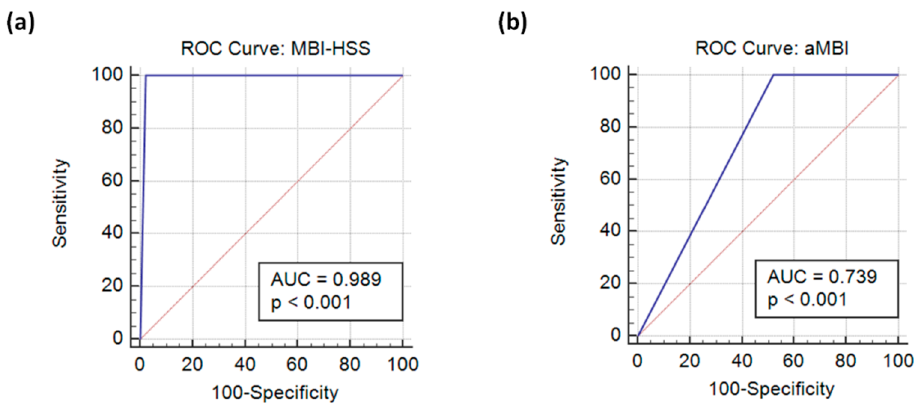
Figure 2. ROC curves for the ( a ) MBI-HSS and the ( b ) aMBI. Table 3. Performance statistics of the MBI-HSS and aMBI as diagnostic tools. Results displayed with 95% confidence intervals (CI).